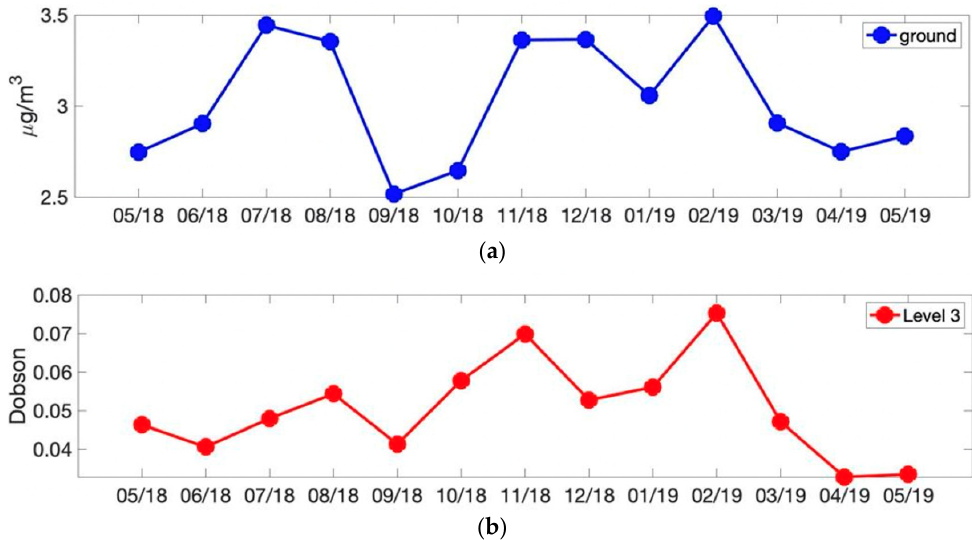
correctly reproduce the salient features of the seasonal cycle, as shown in Figure 12.